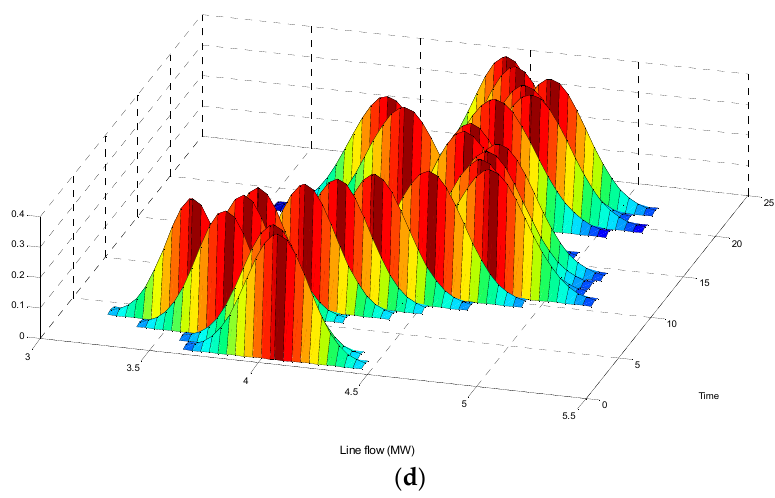
Figure 10. Line flow probabilistic distribution of branch 0–1. ( a ) Case 1; ( b ) Case 2; ( c ) Case 3; ( d ) Case 4. Table 3. Risk assessment results of branch 0–1.